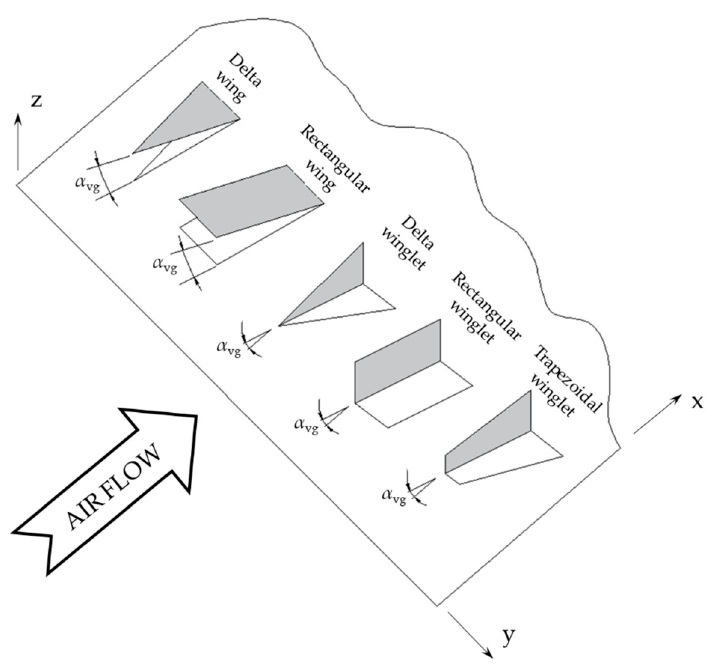
Figure 1. The conventional types of VGs.